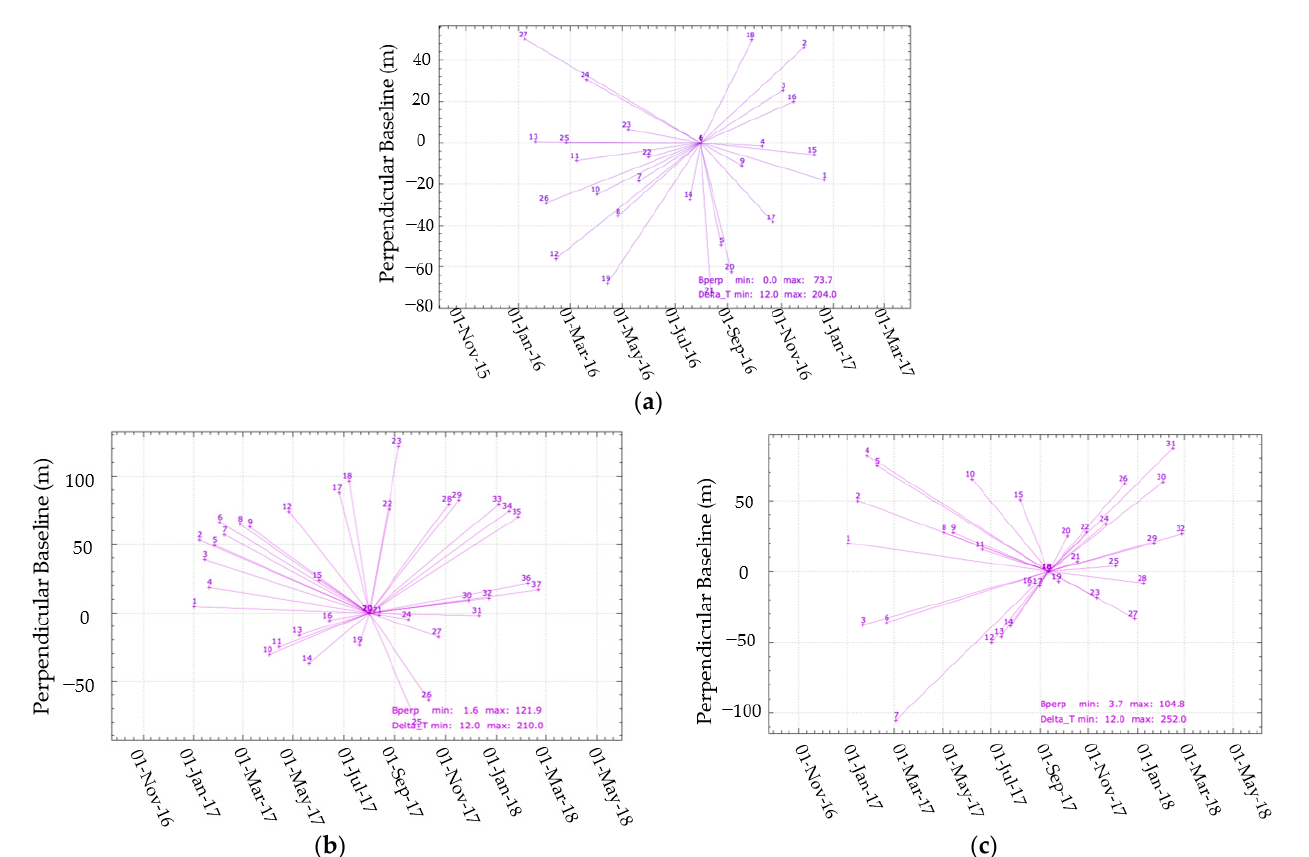
Figure 3. Sentinel-1 interferogram network (single master PS analysis) for the ascending and de- scending frames. ( a ) Descending frame no.71 (Reference date: 20160731); ( b ) Ascending frame no.64 (Reference date: 201707801); and ( c ) Descending frame no.71 (Reference date: 20170912).Each point represents a SAR image, and each line represents an interferogram. X − axis: temporal baseline of the acquisitions. Y − axis: perpendicular baseline of the acquisitions. ( a ) indicates that 27 interferograms comprise the interferogram network for mapping ground subsidence before tunneling. For analysis of ground behavior during the tunneling process, ascending ( b ) and descending ( c ) frames consist of 37 and 32 interferograms, respectively. Table 1. Data used in the PSInSAR TM processing. Table 2. Characteristic parameters and ranges of values in feet for parametric analysis. Path Flight Direction